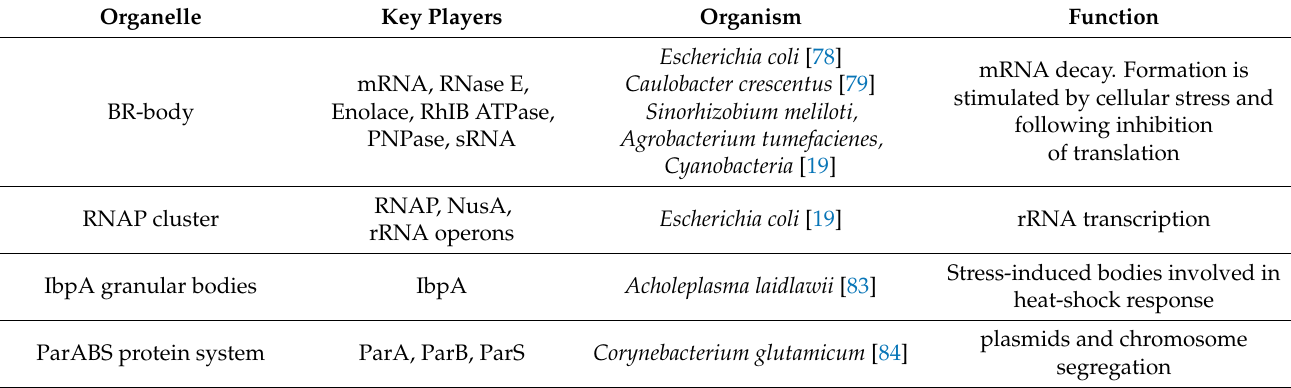
Table 1. Examples of compartments formed or potentially formed by LLPS in prokaryotic